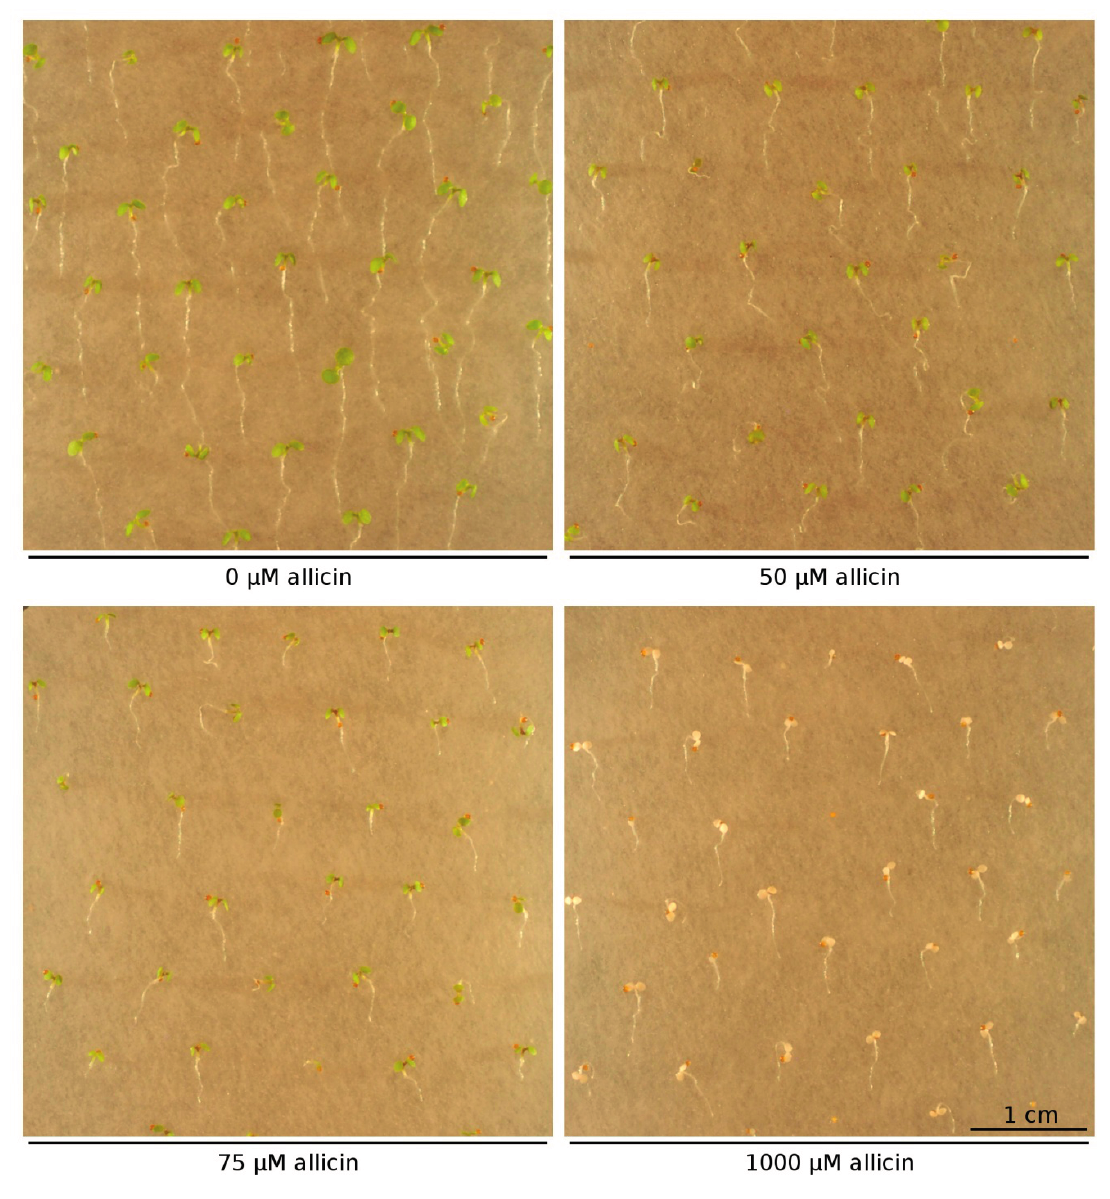
Figure 3. Effect of allicin on seedling development: A. thaliana (Col-0) wild type 48 h after allicin treatment. In this experiment, seeds were set on sterile filter papers which were placed on Murashige & Skoog (MS) medium. After stratification at 4 °C for 48 h, germination and growth took place with the Petri plates tilted to an angle of approx. 20° from vertical to ensure unidirectional root growth according to root gravitropism. After three days of cultivation, filter papers were transferred to MS media that contained different amounts of allicin. Pictures were taken 48 h after treatment. For the sake of clarity only a small representative fraction of seedlings is shown for relevant